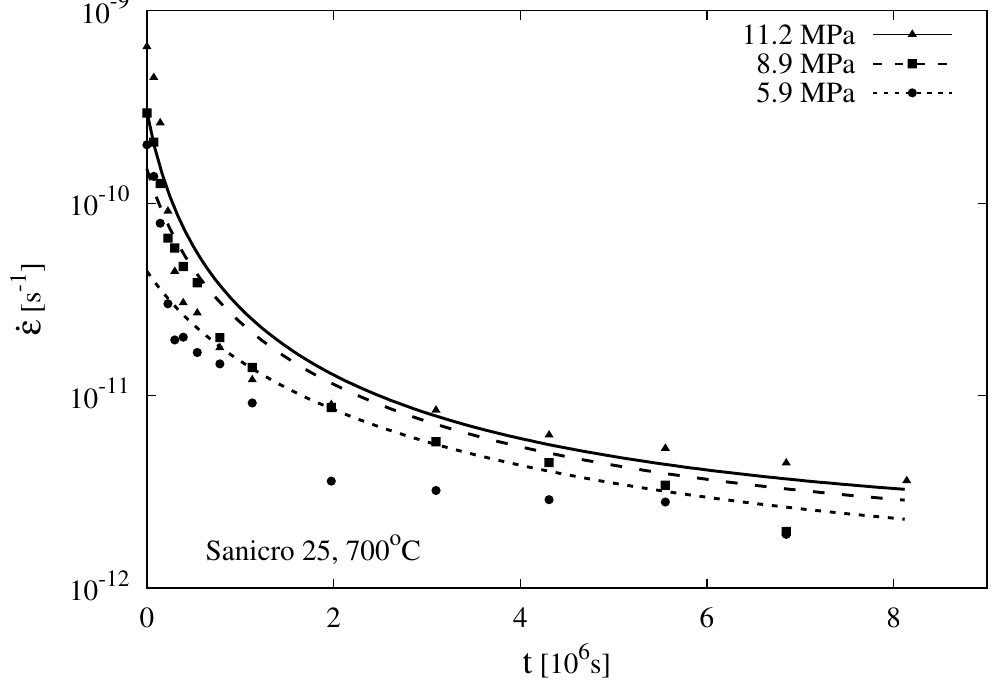
Figure 5. Creep rate dependence on time for Sanicro 25 at 700 ◦ C and low stresses [9] (points) compared to model results